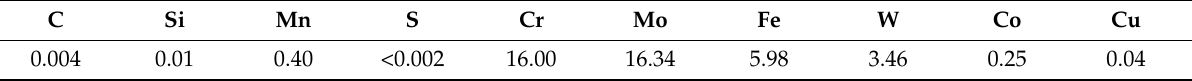
Table 1. Chemical composition of the as-received C276 superalloy (wt.%).